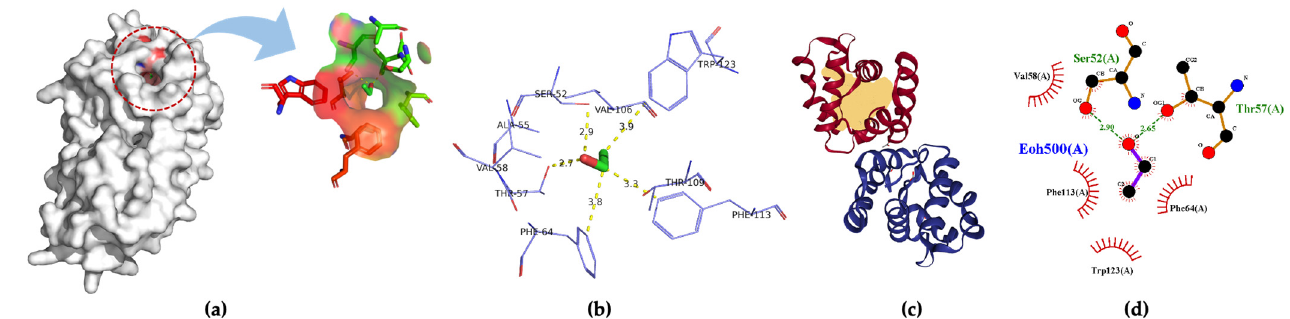
Figure 3. ( a ) 3D visualization of the docking model; ( b ) binding residues identification; ( c ) best position of predicted binding pocket; ( d ) 2D ligand–protein interaction diagrams of odorant binding protein LUSH from Drosophila melanogaster (PDB ID:1OOF) with ethanol.